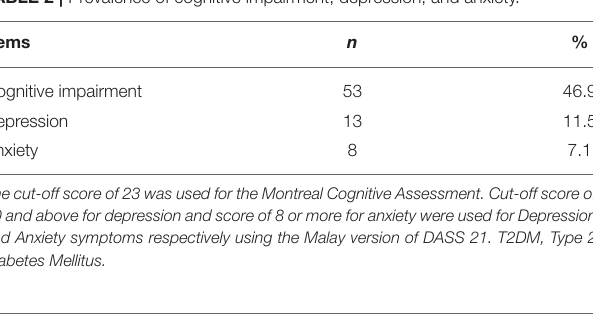
TABLE 2 | Prevalence of cognitive impairment, depression, and anxiety.